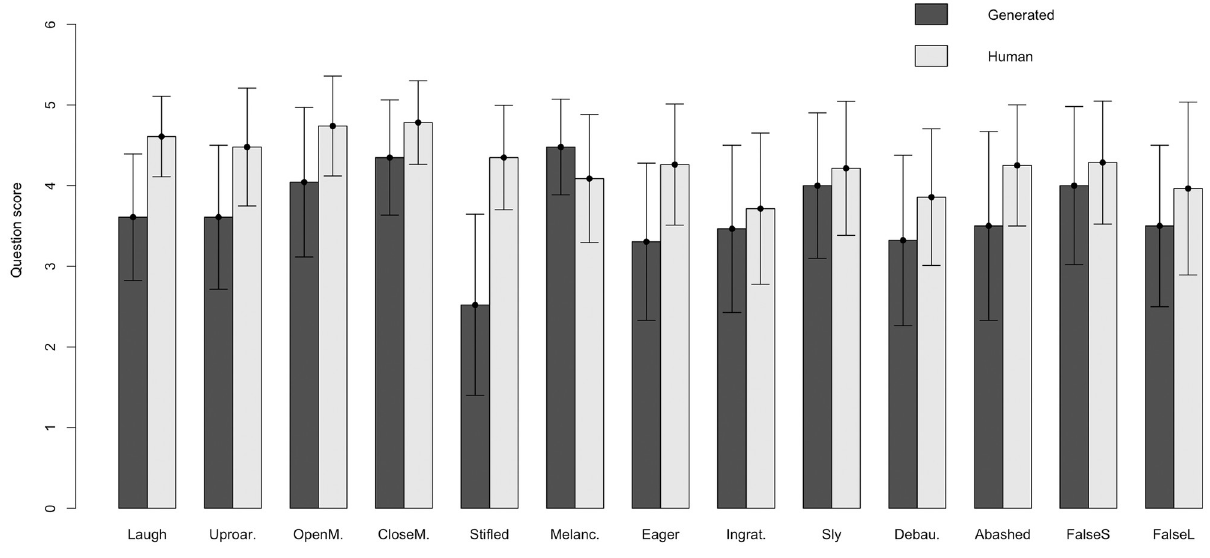
Fig 8. Comparison of the question scores for each expression performance (real vs